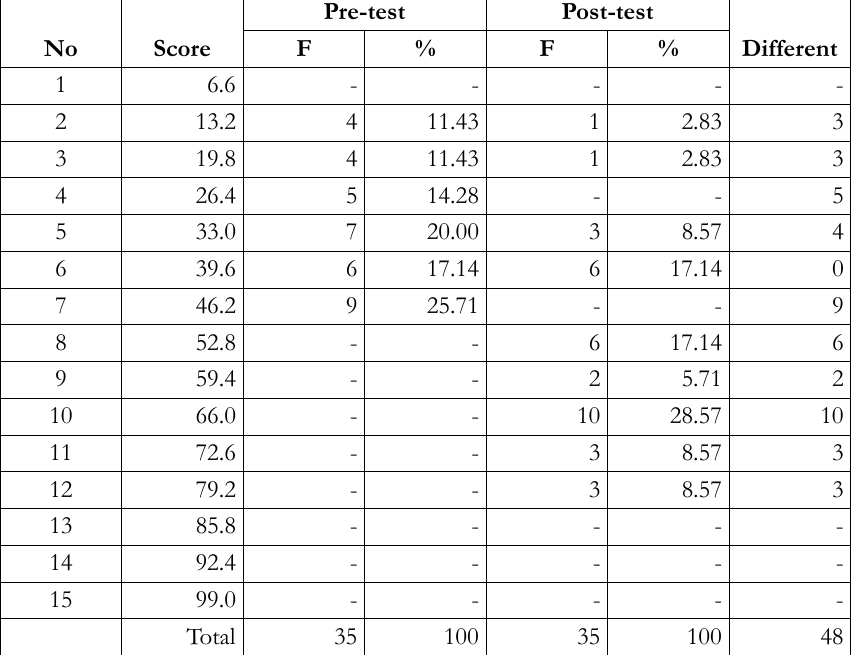
Table 4. Pre-test and post-test result of experimental class